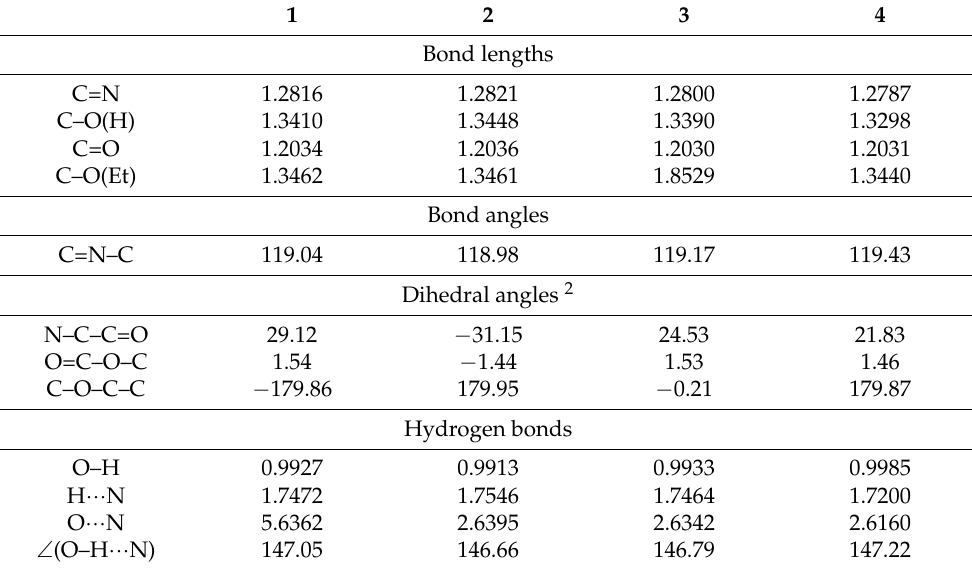
Table 2. Selected bond lengths (Å) and angles (°) in the structures of 1–4 , obtained by using the B3LYP/6-311++G(d,p) method 1 .